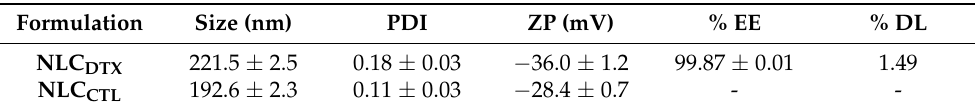
Table 2. Physicochemical properties (size, PDI, PZ, % EE and % DL) of the NLC formulation selected by factorial design for DTX delivery, and its